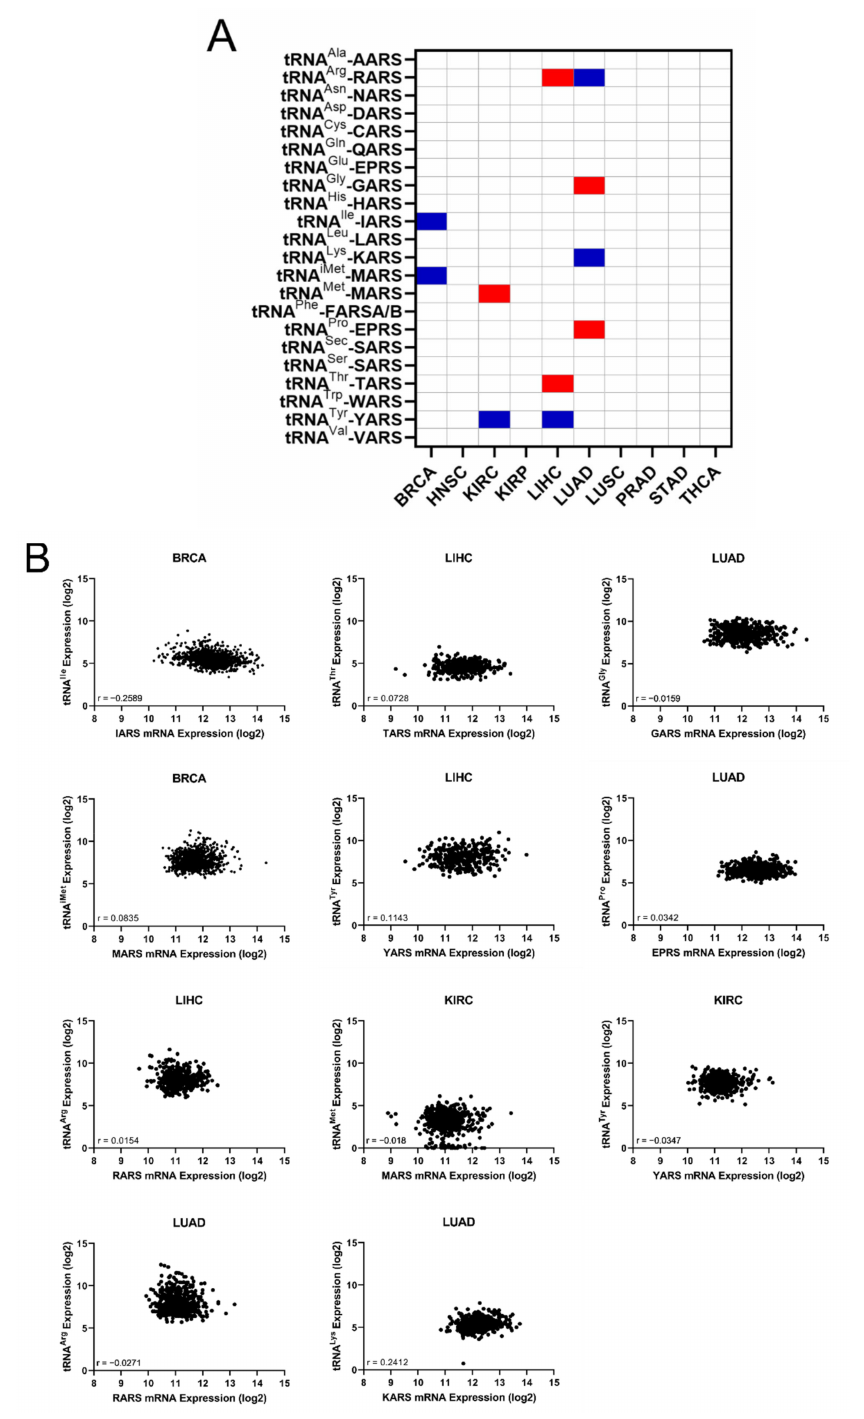
Figure 6. Concomitant ARS and tRNA expression deregulation in tumours. ( A ) Concomitant deregulation of ARS and tRNA expression in tumours affecting patient survival. Red squares denote ARS and tRNA overexpression associated with worse patient survival, while blue squares denote upregulation of ARS, but downregulation of their cognate tRNA expression and association with worse patient survival. This panel was generated based on the p -values of the data shown in Figures 3A and 5A. ( B ) Correlation of ARSs mRNA and their cognate tRNA expression. The Spearman correlation coefficient (r) is